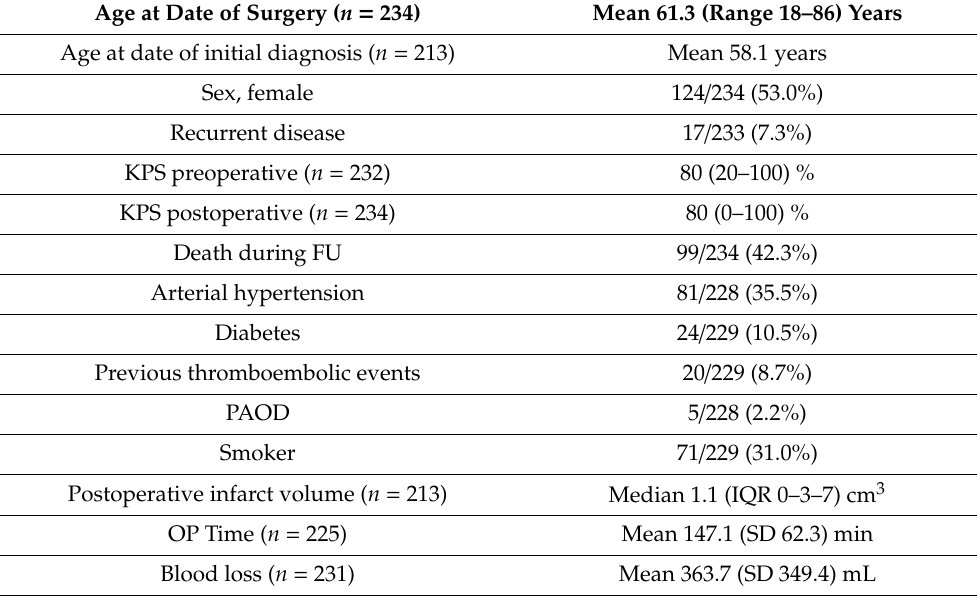
Table 1. Patient